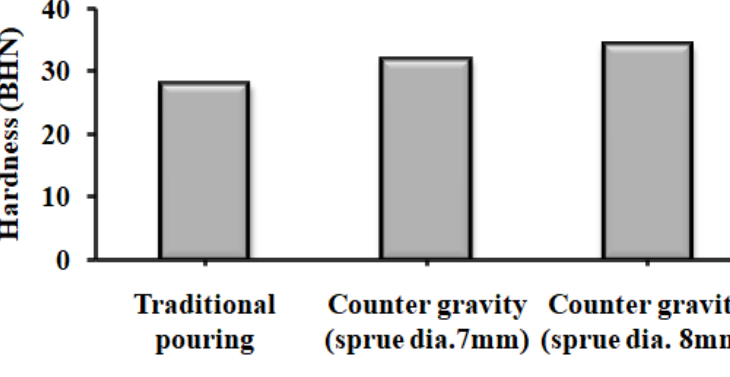
Figure 12. Hardness of fabricated